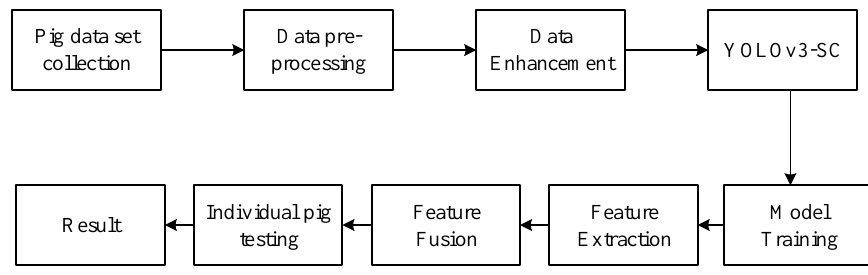
Figure 2. Technical route of the proposed pig detection